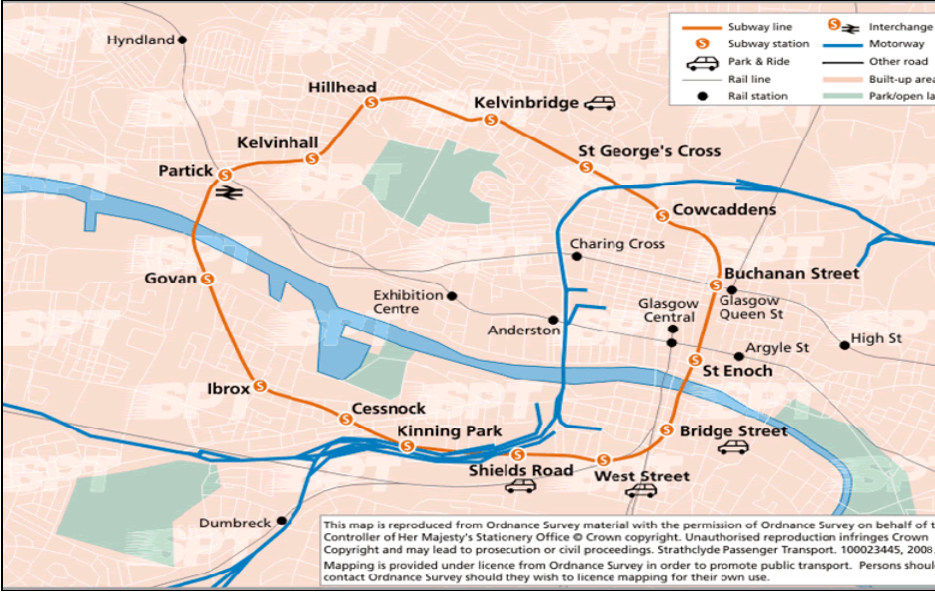
Figure 6. The Glasgow Subway System (Source: